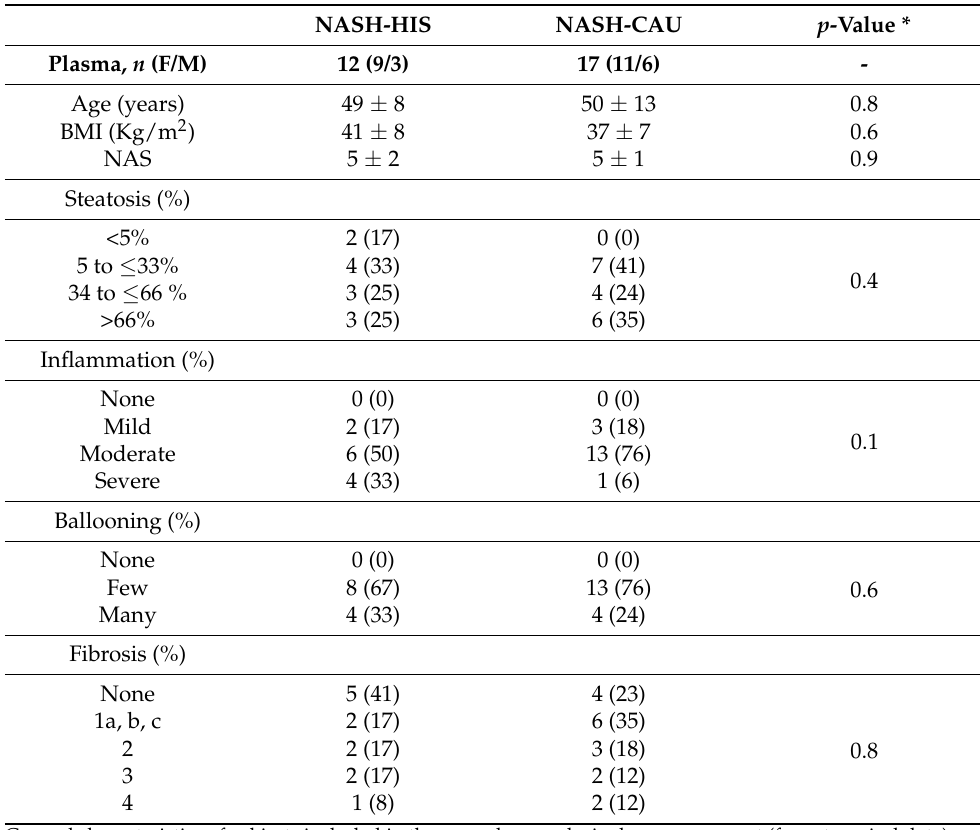
Table 2. Demographic, clinical, and histological characteristics of NASH subjects in secondary